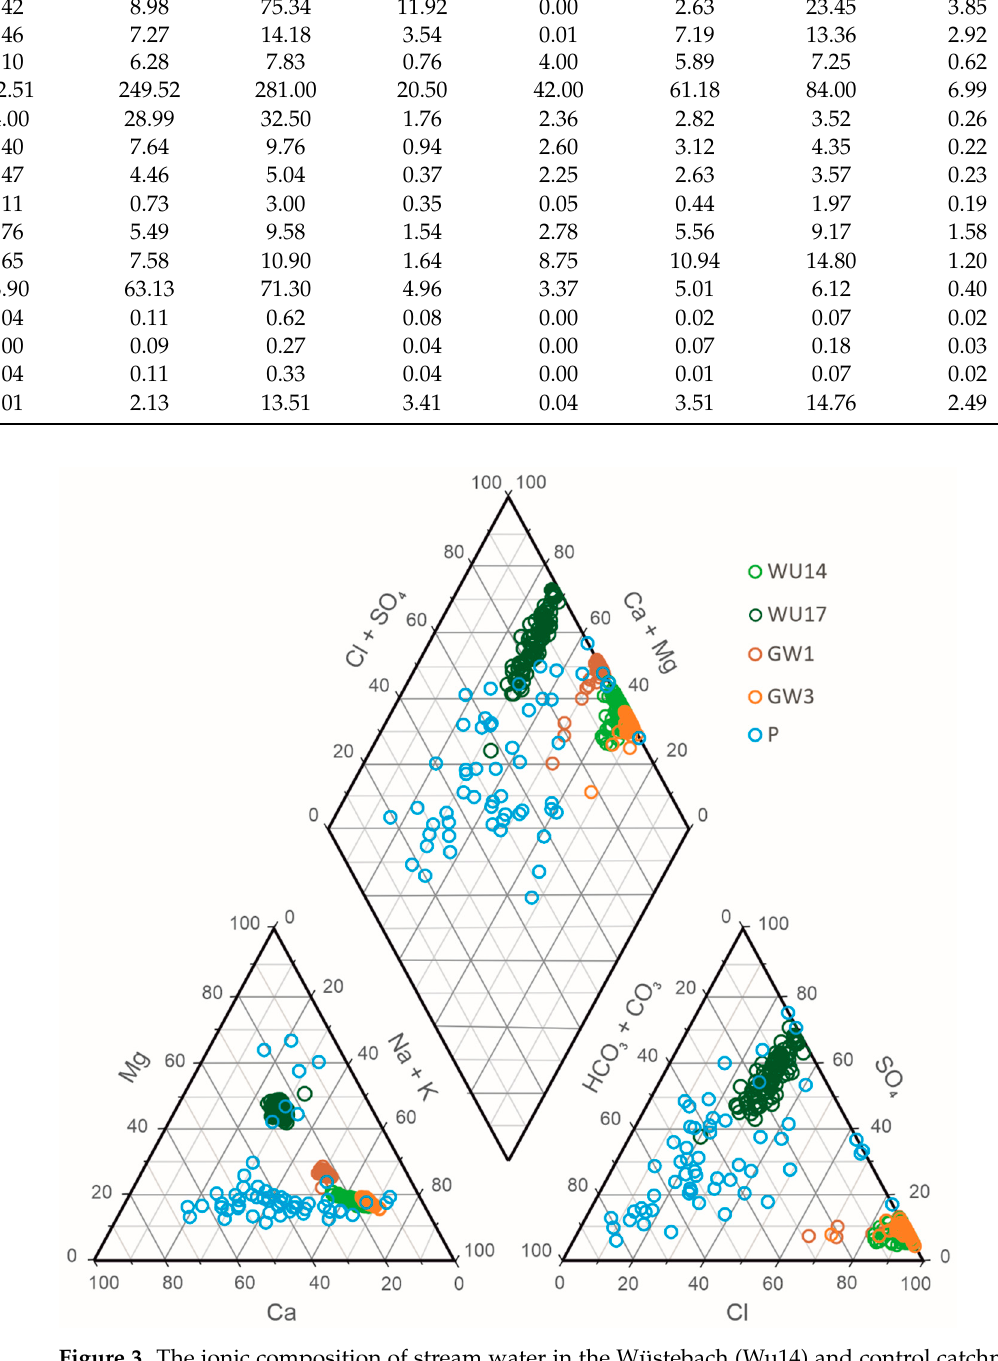
Figure 3. The ionic composition of stream water in the Wüstebach (Wu14) and control catchment (Wu17), groundwater on the slope (GW1) and in the riparian zone (GW3), and precipitation (P) in the pre-deforestation period.